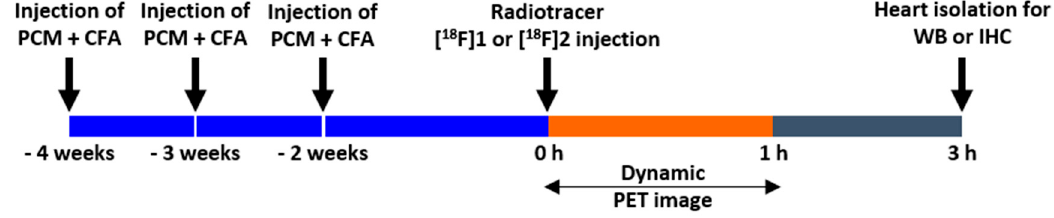
Figure 5. microPET imaging protocol.